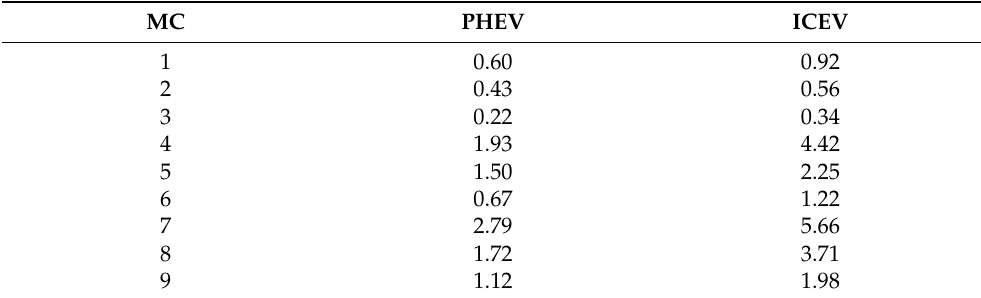
Table A2. Average cost (£) per km for both vehicle types.